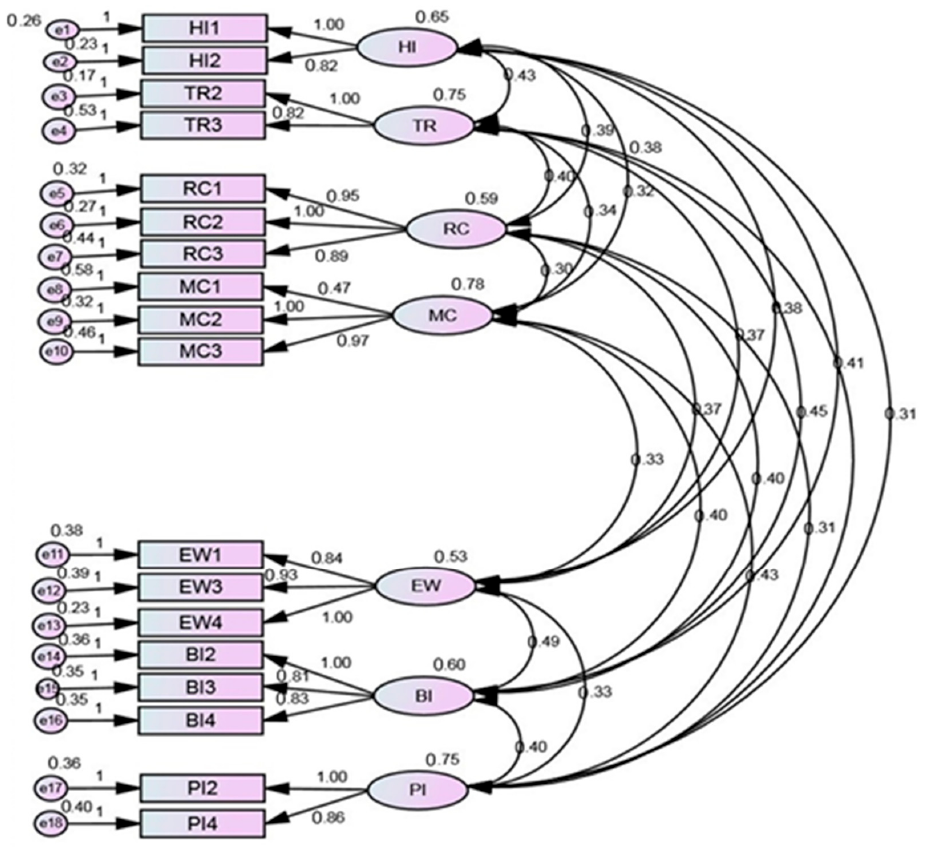
Figure 2. Measurement model of the study. Table 3. Constructs correlation.